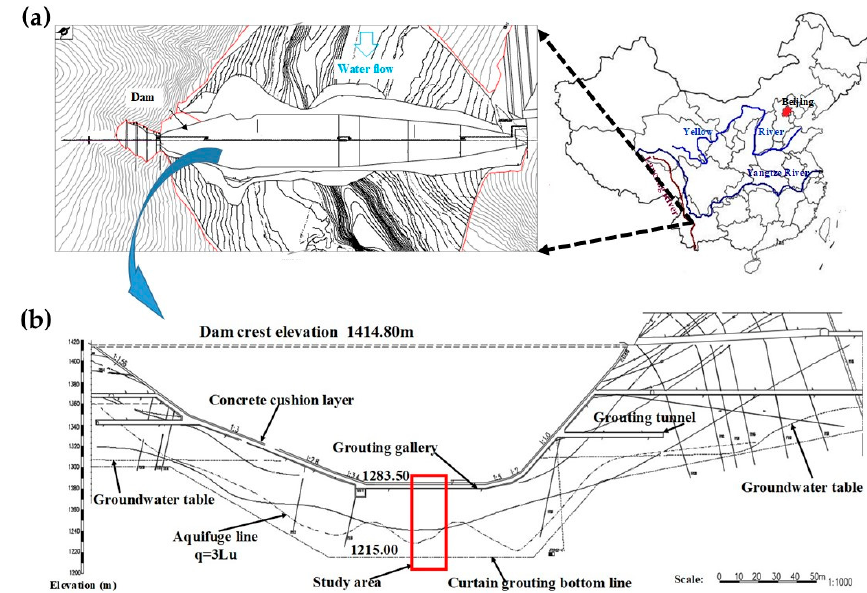
Figure 4. The project profile: ( a ) the layout of project and ( b ) the study area.